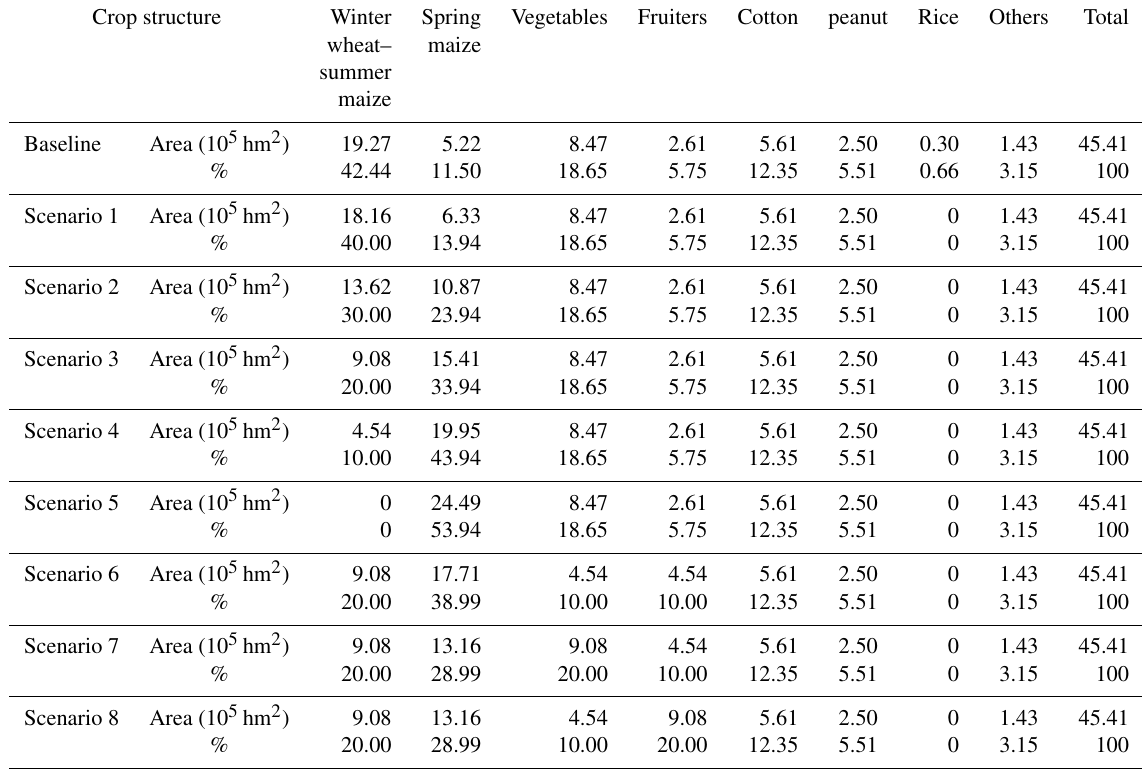
Table 3. Crop structure planning scenarios for the Hebei southern plain. Crop